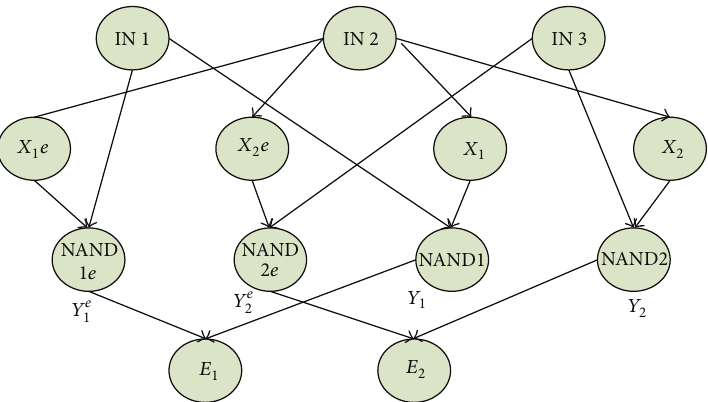
Figure 5: Bayesian network representation of the desired circuit.